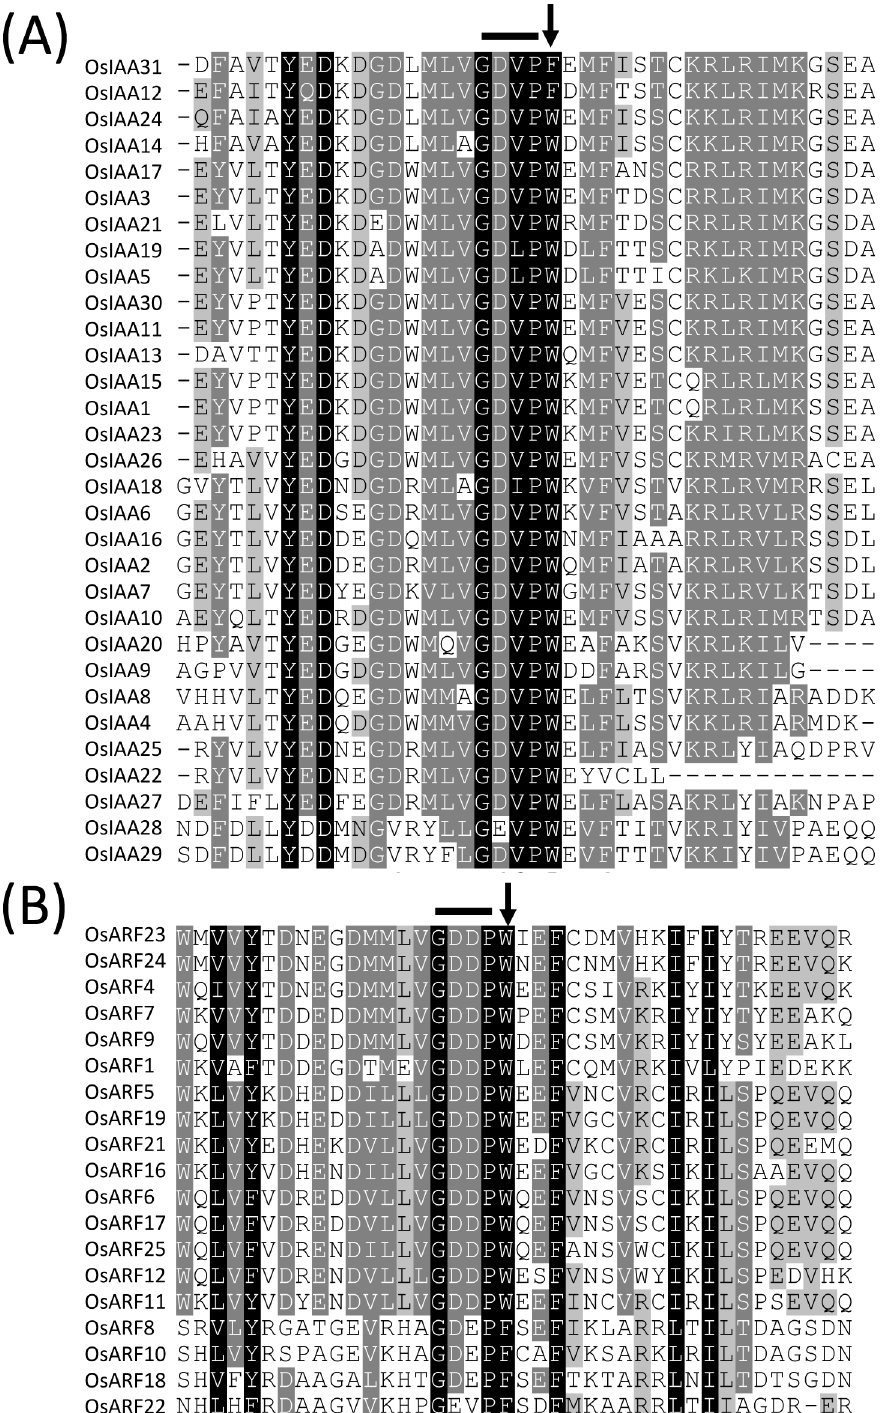
Figure 3. The W residue in Domain IV is conserved in both OsIAAs and OsARFs. (A) The alignment of Domain IV of OsAux/IAAs in rice, the conserved W is marked by the arrow. Conserved GDVP motif is indicated by thick line above the alignment. (B) The alignment of Domain IV of OsARFs in rice, the conserved W is marked by the arrow. Conserved GDDP motif is indicated by thick line above the alignment. doi:10.1371/journal.pone.0085358.g003 development from fertilization [32], arf19 shows insensitivity to previously identified arf2/hss , arf3/ett , arf5/mp , and arf7/nph4 mutants, suggesting that there are functional redundancies among auxin and ethylene [33]. Identification and characterization of T- DNA insertion lines for 18 of the ARFs showed that most of the the ARF proteins [34]. lines fail to show an obvious growth phenotype except for the